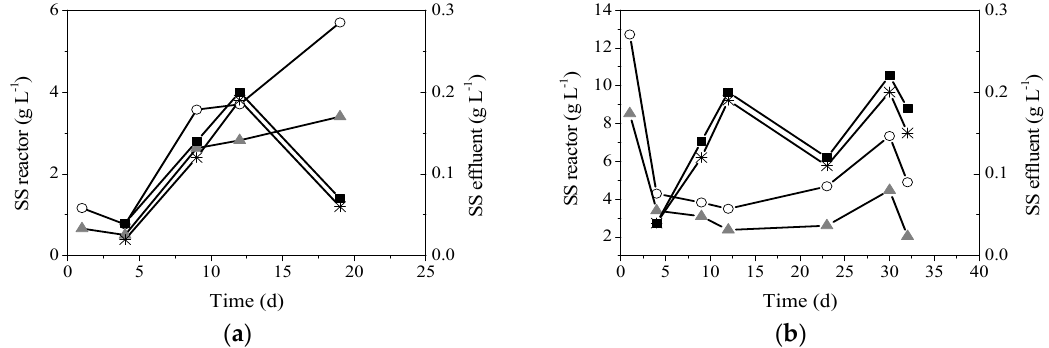
Figure 3. Total suspend solids (TSS) and Volatile suspend solids (VSS) in the reactors and effluent concentrations: ( ○ ) TSS reactor; ( ▲ ) VSS reactor; ( ■ ) TSS effluent; ( * ) VSS effluent. ( a ) SBR I and ( b ) SBR II.